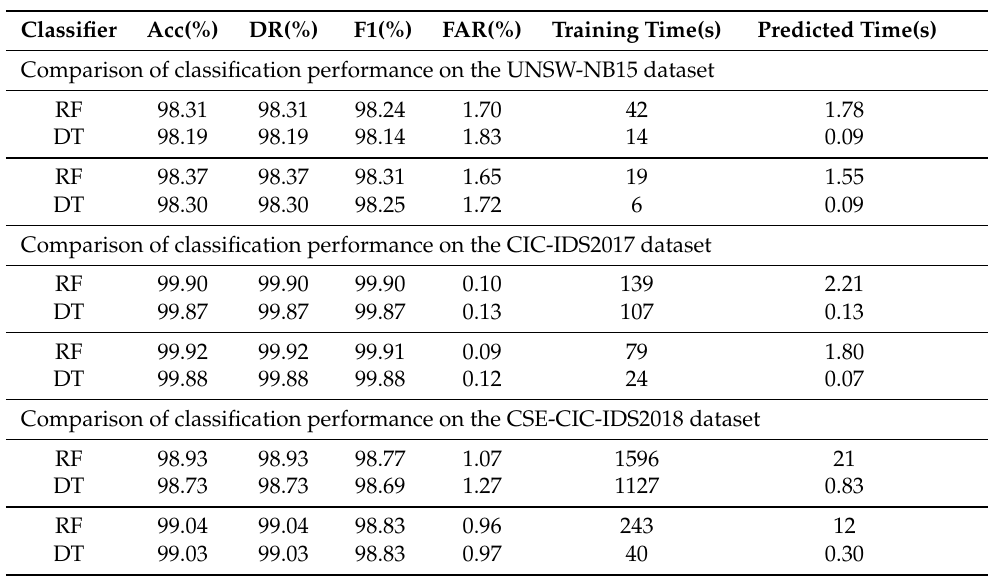
Table 2. Classification performance based on the different